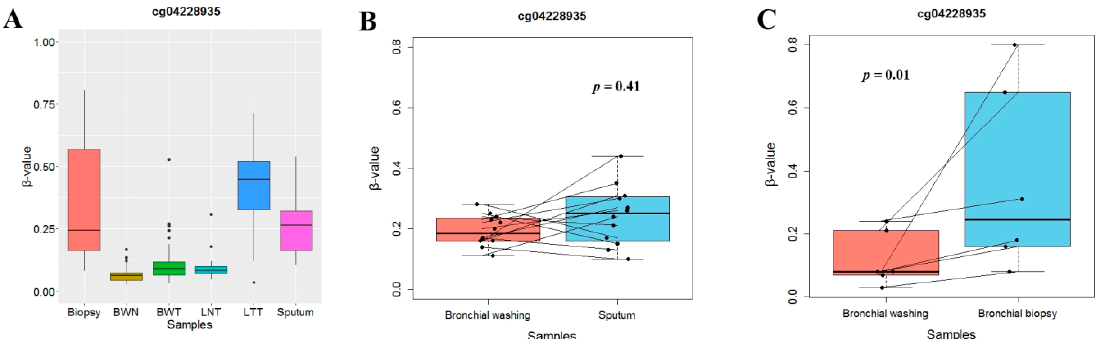
Figure 3. Comparison of RUNX1 methylation levels among different types of specimens. (A) The methylation levels of a CpG (cg04228935) selected for NSCLC prediction were compared among